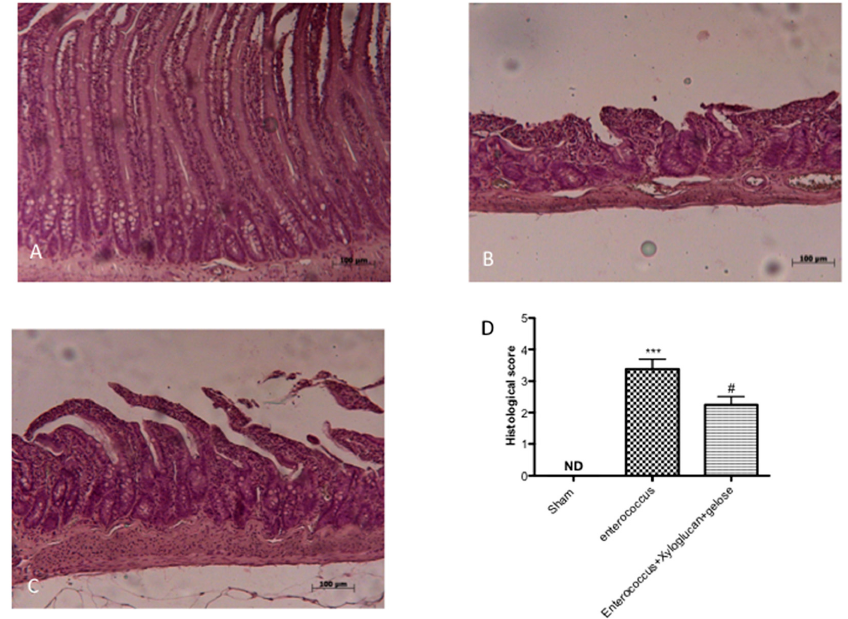
Figure 2. ( A ) The sham group; ( B ) Intestine from E. hirae inoculated rats showed transmural necrosis, edema, and leukocyte infiltration in the submucosa of tissue compared to the sham group; ( C ) Xyloglucan + gelose treatments appreciably reduced the degree of tissue injury; and ( D ) The histological score. Values are means ± SEM of 10 animals for each group. *** p < 0.001 vs. Sham, # p < 0.05 vs. E. hirae